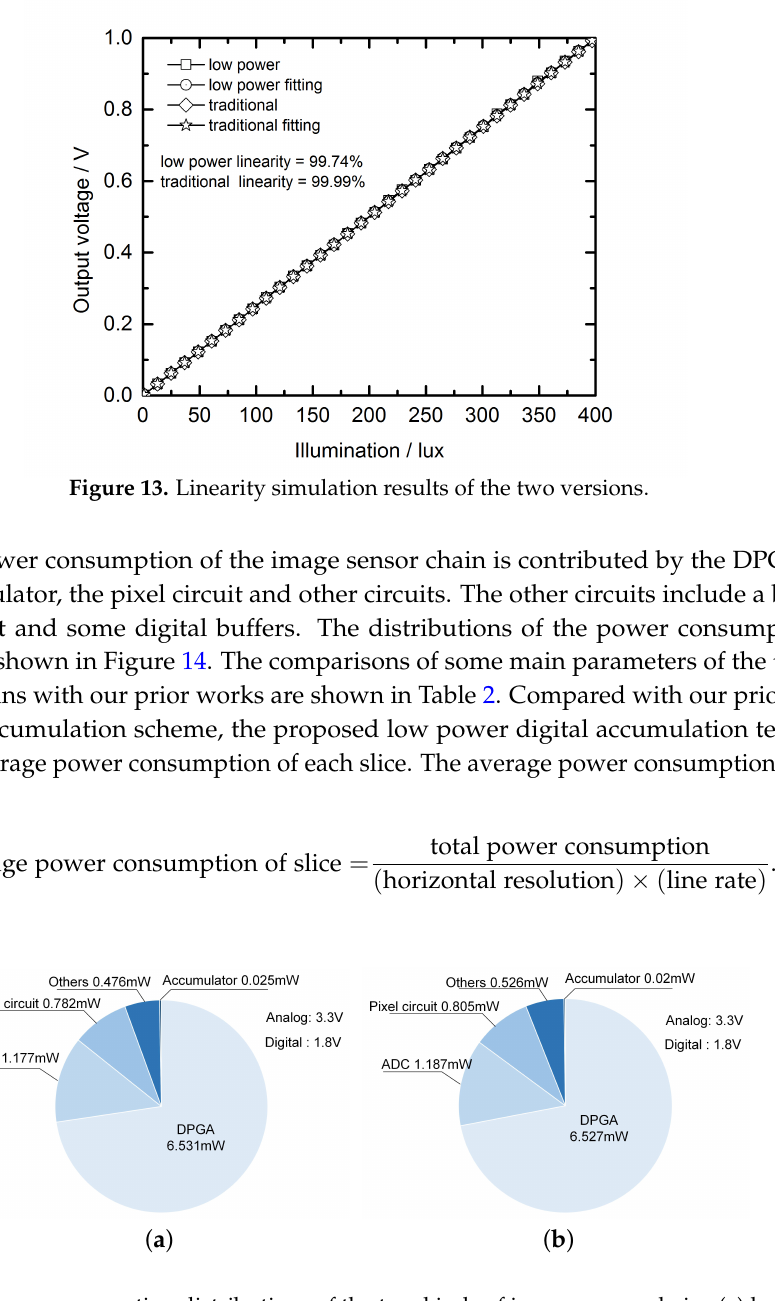
Figure 14. Power consumption distributions of the two kinds of image sensor chains ( a ) low power accumulation scheme; and ( b ) traditional accumulation